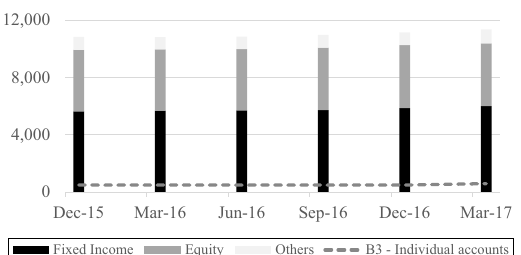
Figure 2. Retail investors in the